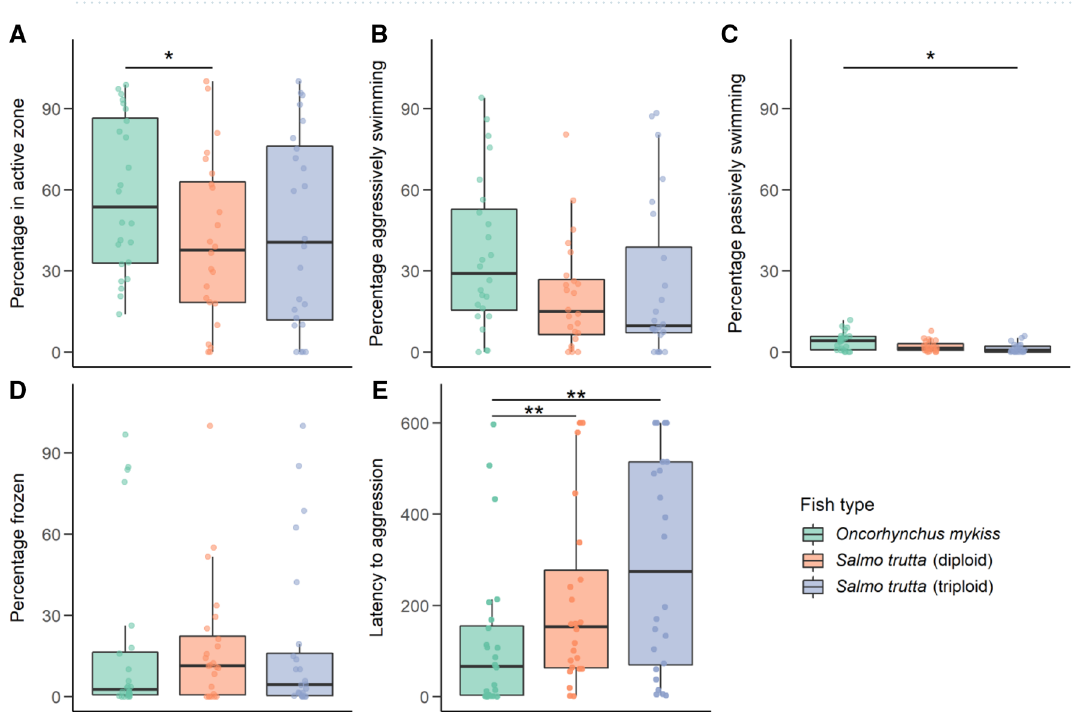
Figure 4. Boxplots showing the variables measured during the mirror test, with median and interquartile range plotted and overlayed with raw data points. Asterisks show significance values (* p < 0.05, ** p < 0.01, *** p < 0.001). ( A ) Percentage time spent in the “active zone” adjacent to the mirror, ( B ) percentage of the time in the active zone spent aggressively swimming against the mirror, ( C ) percentage of the time in the active zone spent passively swimming away from the mirror, ( D ) percentage of the time in the active zone spent being still, ( E ) latency to initiate aggressive swimming against the